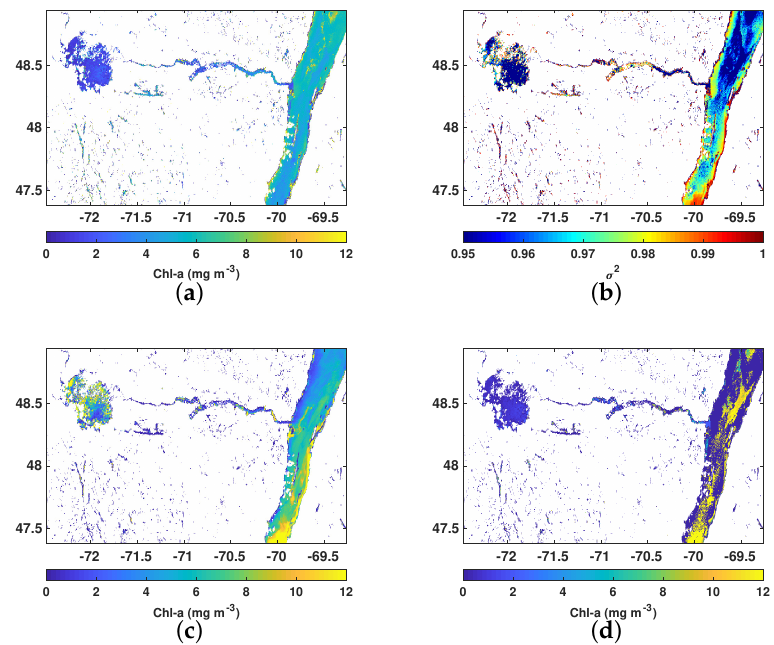
Figure 10. Region 1: Estimated Chl-a concentration ( a ) and the corresponding certainty map ( b ). Chl-a concentration map by the NNs ( c ) and OC4 ( d ). The unit of Chl-a is mg m − 3 , and the certainty (variance) is unitless.